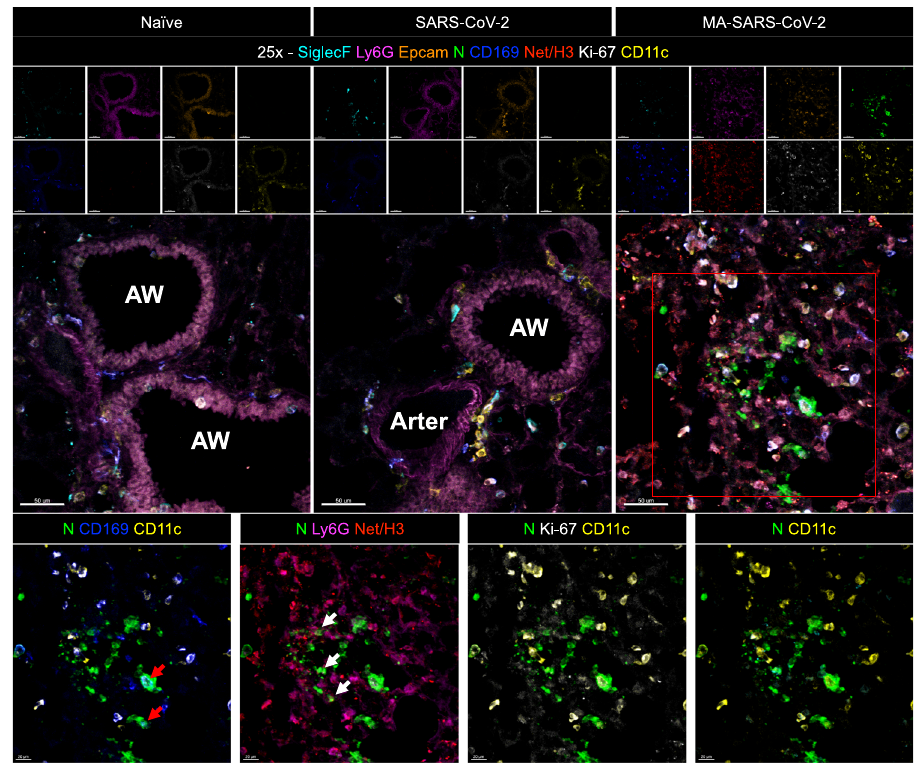
Fig. 4 Multiplex immuno fl uorescence imaging of lung tissues from naïve, SARS-CoV-2, or MA-SARS-CoV-2-infected 129S1 mice at 3 days post- infection immunostained for Siglec-F (teal), Ly6G (magenta), Epcam (orange), SARS-CoV-2 N protein (green), CD169 (blue), Net/H3 (red), Ki-67 (white), and CD11c (yellow). (Left to right) The red box is magni fi ed showing SARS-CoV-2 N-Protein with CD169 + AM, Neutrophils, Ki-67 + AM, and Siglec-F + AM. White arrowheads indicate SARS-CoV-2 + /Ly6G + /Net/H3 + cells, red arrowheads indicate SARS-CoV-2 + /CD169 + /CD11c + cells. AW: airway. Arter: arteria. Scale bar: 50 μ m and 20 μ m. N = 4 mice per group and one representative image per group is shown.